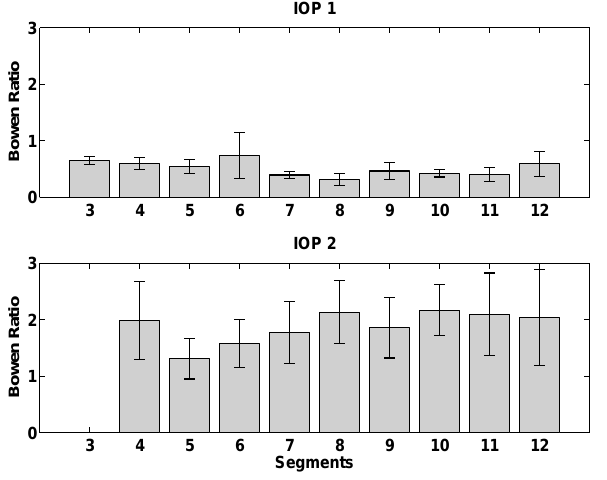
Fig. 8. Average evaporative fraction per segment with error bars (= standard deviation of single passes) along flight track during IOP1 (18–22 April) and IOP2 (7–14 September) at